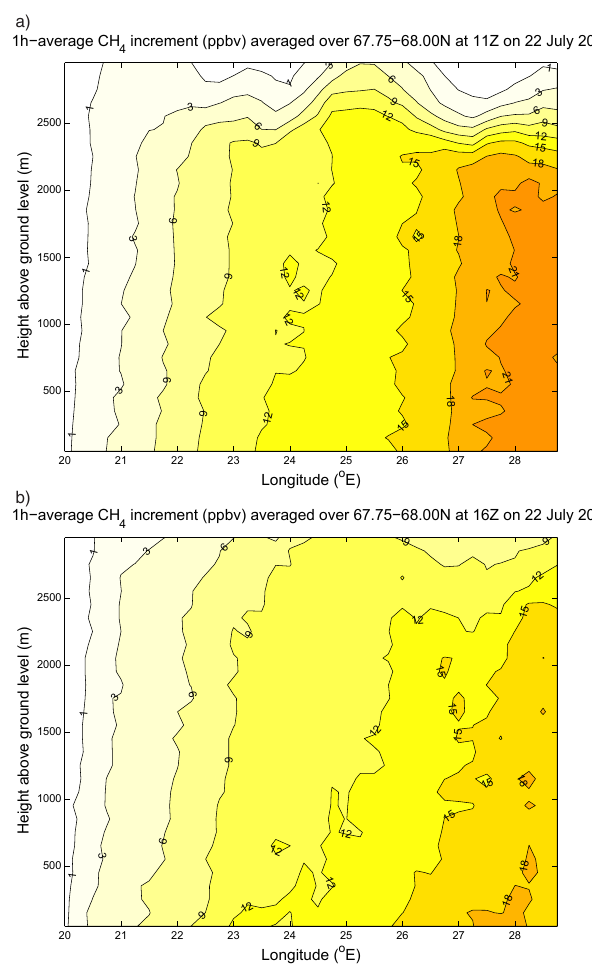
Figure 6. Dispersion model results from NAME for the mixing ratio of CH 4 originating from the local wetlands in a cross section of the atmosphere averaged over 67.75 to 68.00 ◦ N and 1h surrounding 11:00GMT on 22 July 2012. The local wetland CH 4 source was defined as a 1.2mgCH 4 h − 1 m − 2 source emitted from the ground between 20 and 28 ◦ E and between 67 and 69.5 ◦ N. Figure 6b shows the same but for a 1h average surrounding 16:00GMT on the same